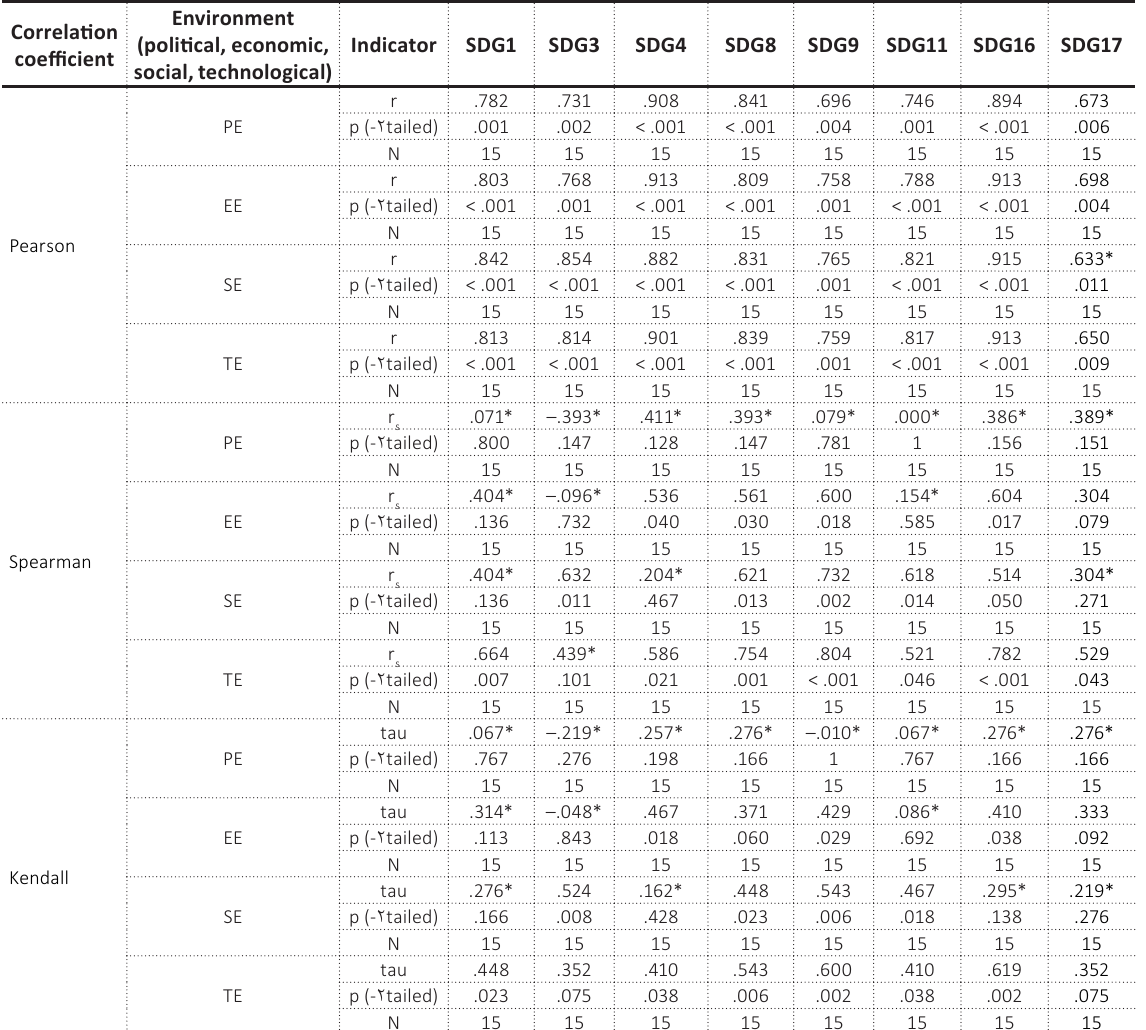
Source: Authors’ elaboration